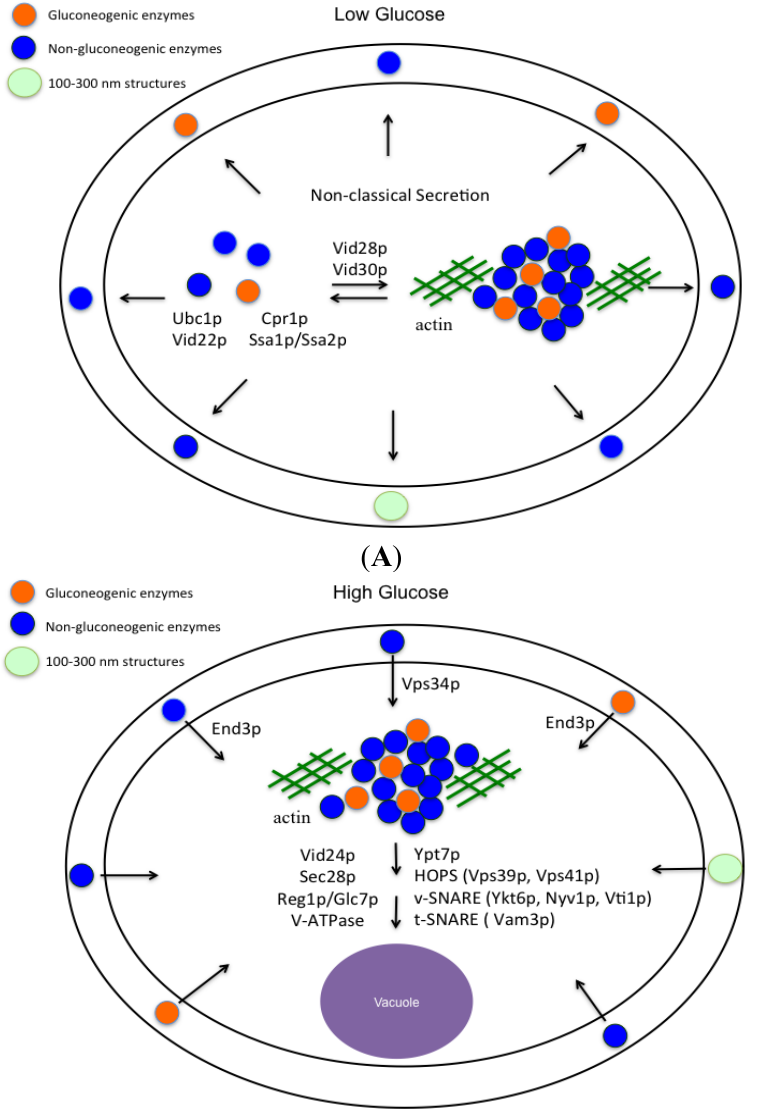
Figure 6. Vid vesicles are secreted into the periplasm during glucose starvation and are internalized following glucose addition. When yeast cells are grown in low glucose, Vid vesicles that carry gluconeogenic enzymes and non-gluconeogenic enzymes are secreted into the periplasm via the non-classical secretory pathway ( A ). In the periplasm, 100–300 nm structures are also present ( A ). In the cytoplasm, FBPase is associated with Vid vesicles. The association is dependent on Ubc1p, Ssa1p/Ssa2p, Vid22p, and Cpr1p. Vid vesicles also aggregate to form large clusters and associate with actin patches. This step requires the VID28 and VID30 genes. Following glucose addition to glucose-starved cells for 30 min, FBPase is internalized ( B ). The internalization requires the endocytosis gene END3 and the VPS34 gene encoding PI3K ( B ). The 100–300 nm structures decrease in number but are still observed at the t = 30 min time point. Following internalization, FBPase is delivered to the vacuole to be degraded, while proteins that are not degraded may be recycled. Vid24p, Sec28p, Reg1p/Glc7p, V-ATPase, Ypt7p, HOPS, v-SNARE and t-SNARE are critical for the post-internalization step in the Vid pathway